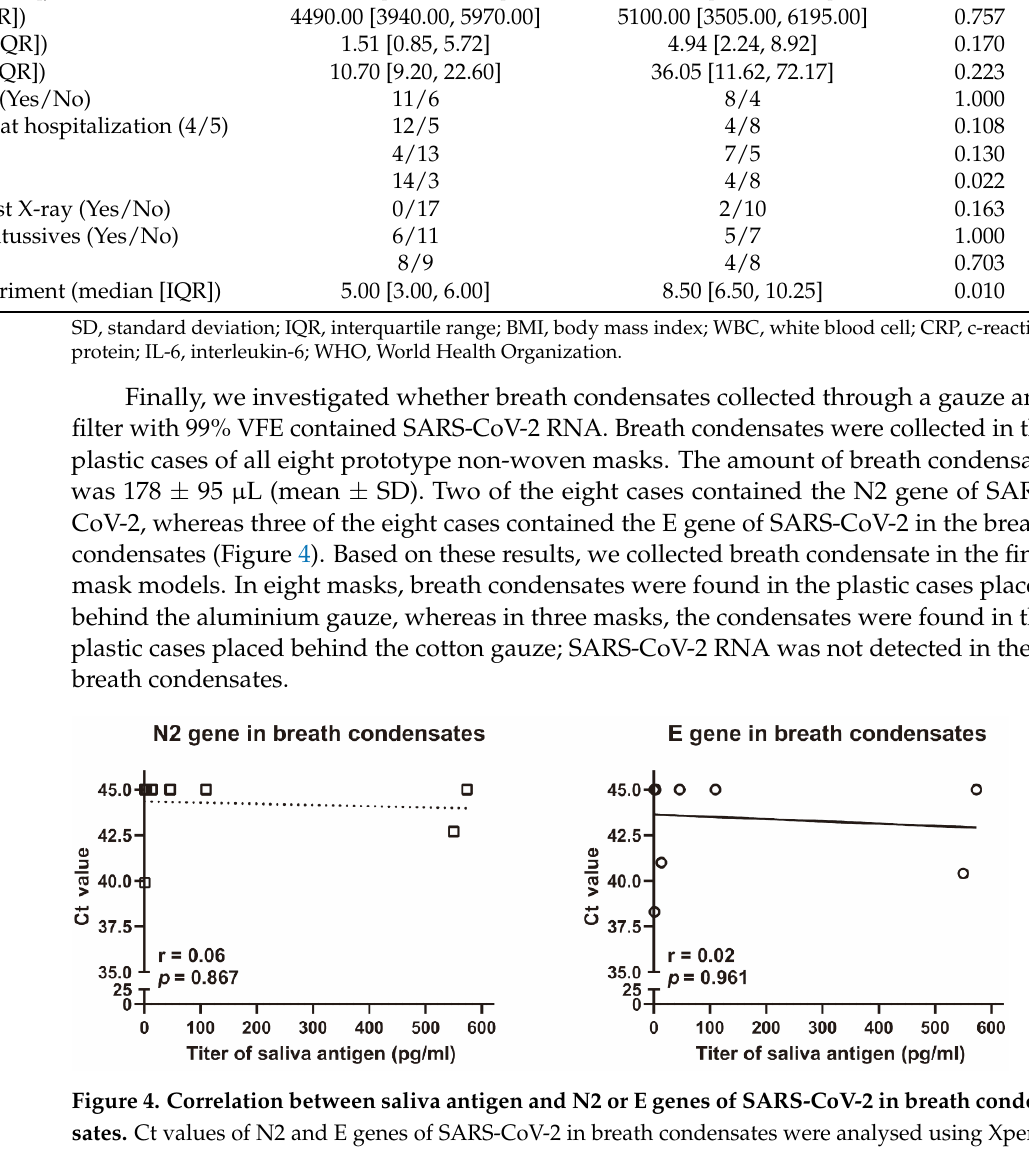
densates. Ct values of N2 and E genes of SARS-CoV-2 in breath condensates were analysed using Xpert ® Xpress SARS-CoV-2. Salivary SARS-CoV-2 antigen was assessed using the Lumipulse G SARS-CoV-2 Ag. The r and p values were evaluated using the Spearman rank correlation test.